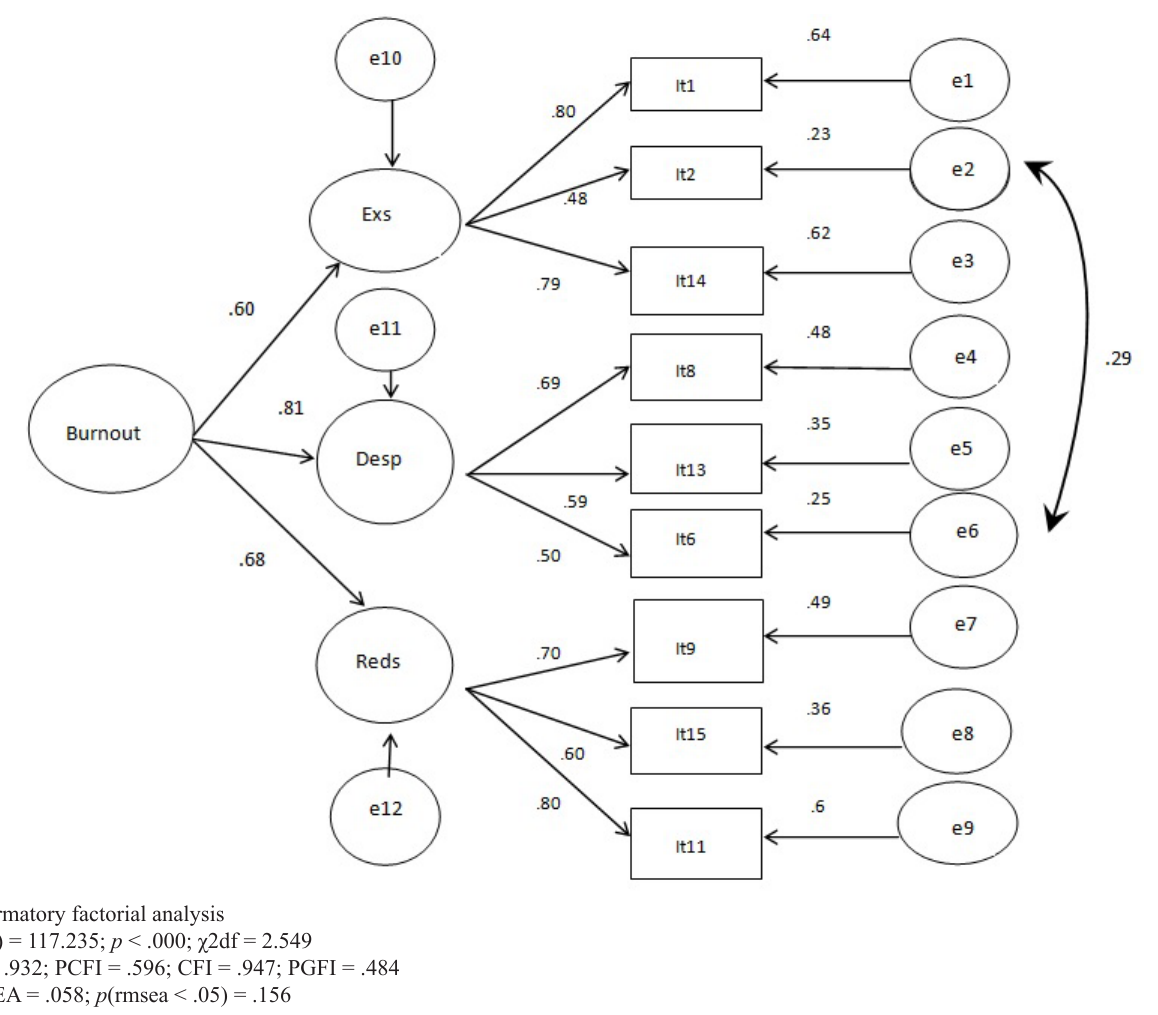
Figure 1. Structural model showing the factorial and individual reliability of items for each factor, as well as correlations among the